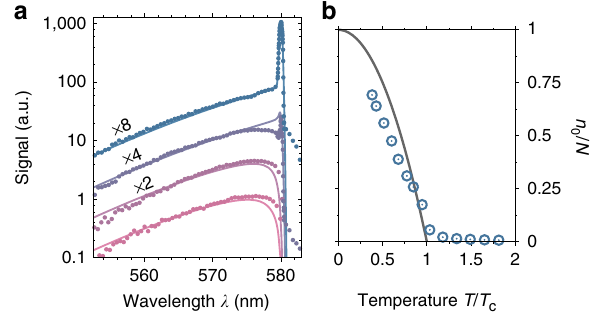
Figure 2 | Spectral photon distribution and condensate fraction. ( a ) Distribution of photon energies for increasing total photon number (circles). For clarity, the spectra have been vertically shifted. The observed spectra agree well with the expected 300K Bose–Einstein distribution functions (solid lines). ( b ) Condensate fraction n 0 / N versus the reduced Due to an imperfect saturation of the population of the thermal cloud, the condensate fraction is observed to be systematically below the theoretically